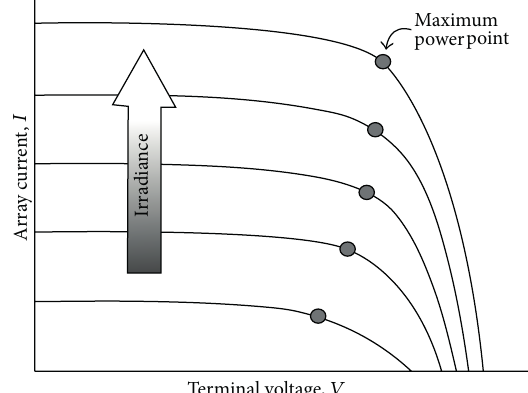
Figure 1: 𝐼 - 𝑉 curves at various solar irradiances [3].